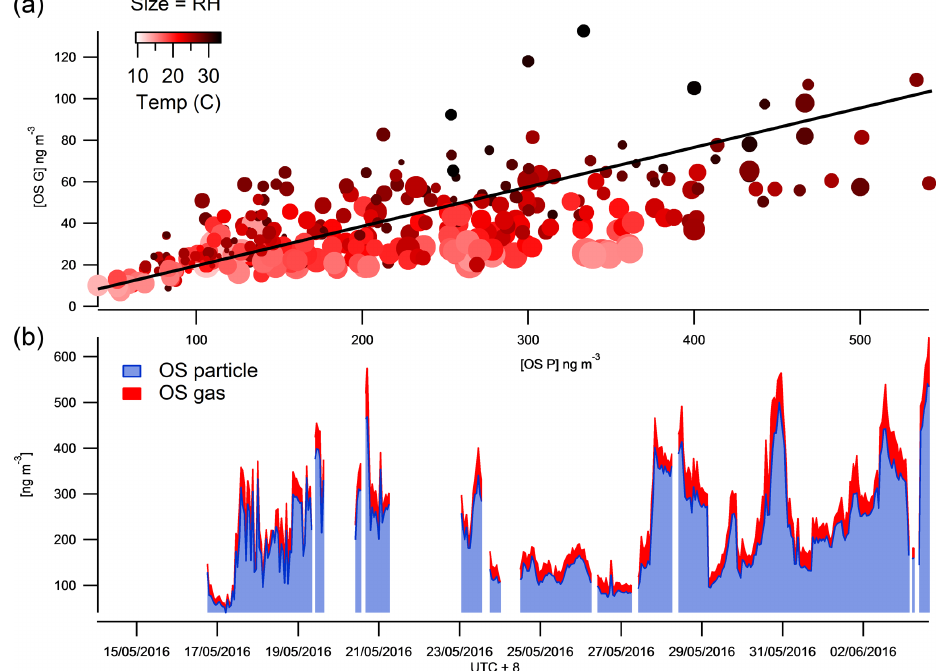
Figure 4. The time series of total SCOs in the gas and particle phases (b) and their correlation colour coded by temperature and size binned by relative humidity (a)